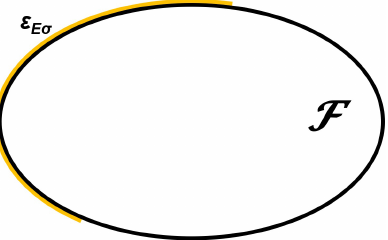
Figure 1. Feasible set in Example 1 and Expected Value standard Deviation Efficient Set.